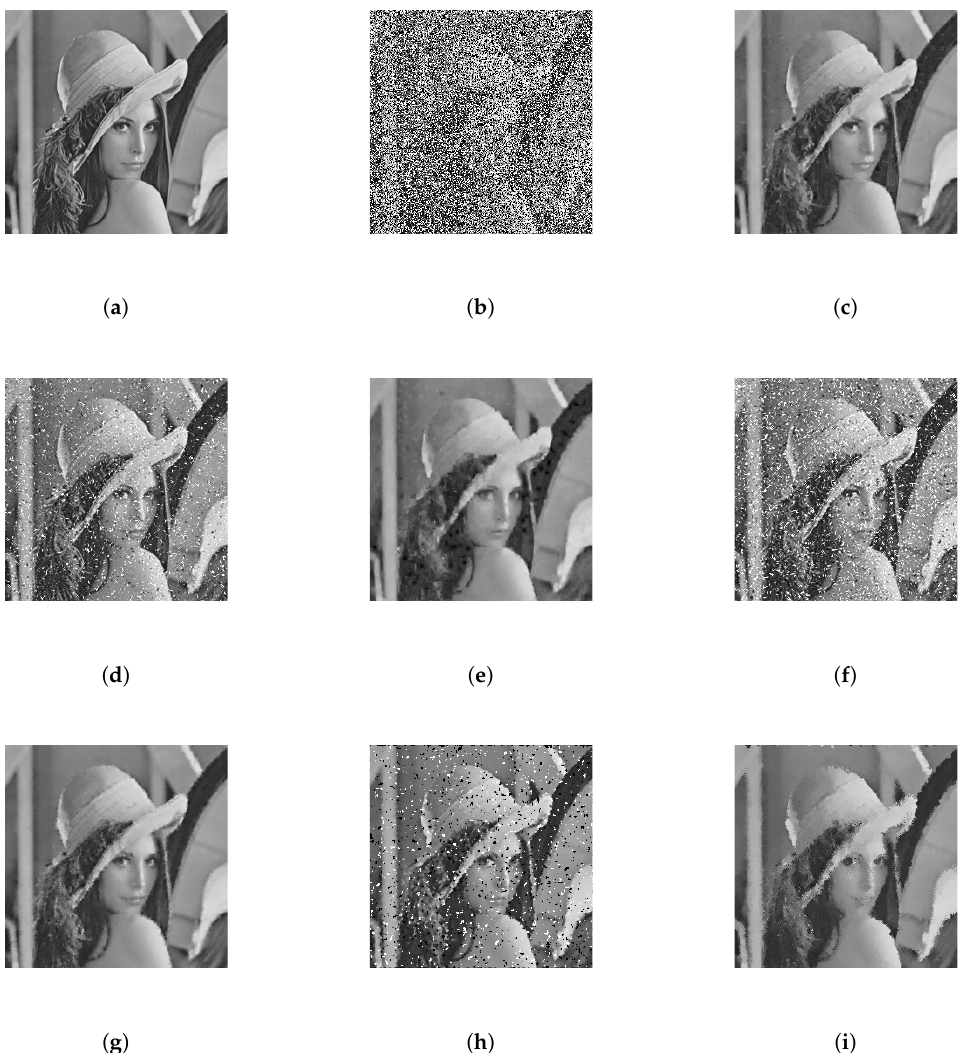
Figure 2. Restoration results of different algorithms in the case of salt-and-pepper noise only. ( a ) original image; ( b ) corrupted image with 70% salt-and-noise noise (6.95 dB); ( c ) reconstructed image obtained by framelet+APG (28.2 dB); ( d ) reconstructed image obtained by framelet+ADMM (26.5 dB); ( e ) reconstructed image obtained by wavelet+APG (26.1dB); ( f ) reconstructed image obtained by wavelet+ADMM (23.7 dB); ( g ) reconstructed image obtained by AM-IEPR (27.6 dB); ( h ) reconstructed image obtained by MED (27.3 dB); ( i ) reconstructed image obtained by AMF (27.4 dB). AM-IEPR: adaptive median filter and edge preserving regularization, MED: median, AMF: adaptive median